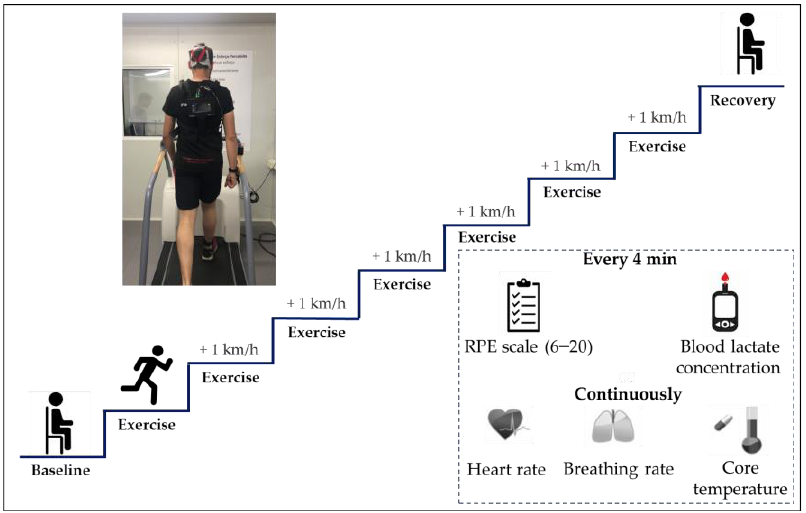
Figure 2. Scheme describing the implemented intermittent incremental running protocol.